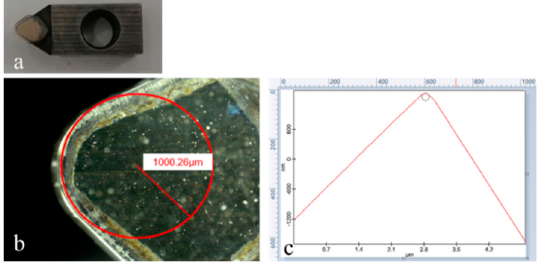
Figure 1. Single-crystal-diamond tool, ( a ) overall view, ( b ) tool nose, ( c ) cutting edge. Single-point diamond-turning experiments were performed with a self-developed vertical machine-tool which is specially designed for ultra-precision cutting, as shown in Figure 2. The main structures of this machine tool include the cast iron base, linear motor, hydrostatic bearing-spindle and CNC control system. The machine can provide a highest rotating-speed of 12,000 rpm, with a position precision of ± 2 μ m. The end-face runout of the spindle is less than 2 μ m, with the vertical structure of the machine tool. As shown in Figure 2b, to realize magnetic-field-assisted single-point diamond face turning, two per- manent magnets with different polarities were installed on the machine worktable. The magnets are made of neodymium iron with three dimensions of 100×50×20 mm. A mag- netic-isolation cover fixture made of 45 steel was used to avoid the interference of the magnetic field on the linear motor. It can shield more than 96% magnetic intensity by testing with a tesla meter. Only one direction is opened to introduce the magnetic field into the workpiece and cutting zone. The remanence and coercive force were 1.18 T and 880 KA/m, respectively. The average magnetic-flux density is 0.38T, and the distance be- tween the two permanent magnets is 190 mm. Figure 2. Single-point diamond-turning experiment, ( a ) machine tool, ( b ) magnetic-field-assisted turning. In line with the previous turning experiments, the cutting speed in this work was altered from 3.2 to 9.6 m/s, the depth of cut was varied from 4 to 12 μ m, and five levels of feed rate were applied in single-factor experiments, as listed in Table 1. Before the exper- iments, a workpiece sample was pre-processed to guarantee surface flatness, with a PCD tool. Based on the previous test, industrial alcohol was used as the cutting fluid during the turning experiments. The cutting force was recorded online with the dynamometer (9119AA2, Kistler, Switzerland). After the experiments, the surface roughness and mor- phology were inspected, using a 3D optical-surface-profiler (New View 7300, Zygo, Con- necticut, USA). The chip morphology was observed using the electron scanning micro- scope (SEM, Phenom Pro, Netherlands). Table 1. Single-point diamond-turning parameters.